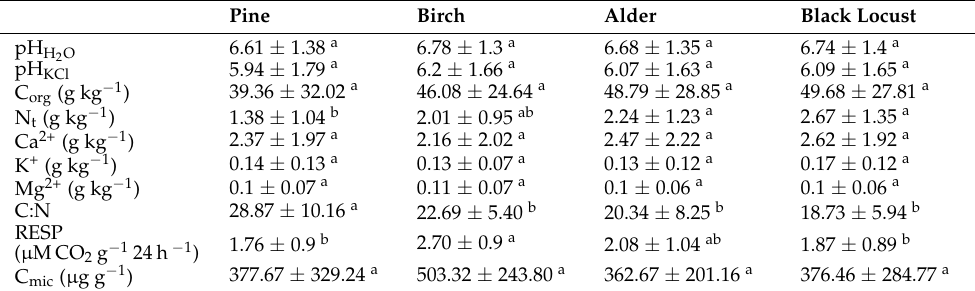
Table 4. Tree species effect on soil chemical properties and microbial activities: C org —organic